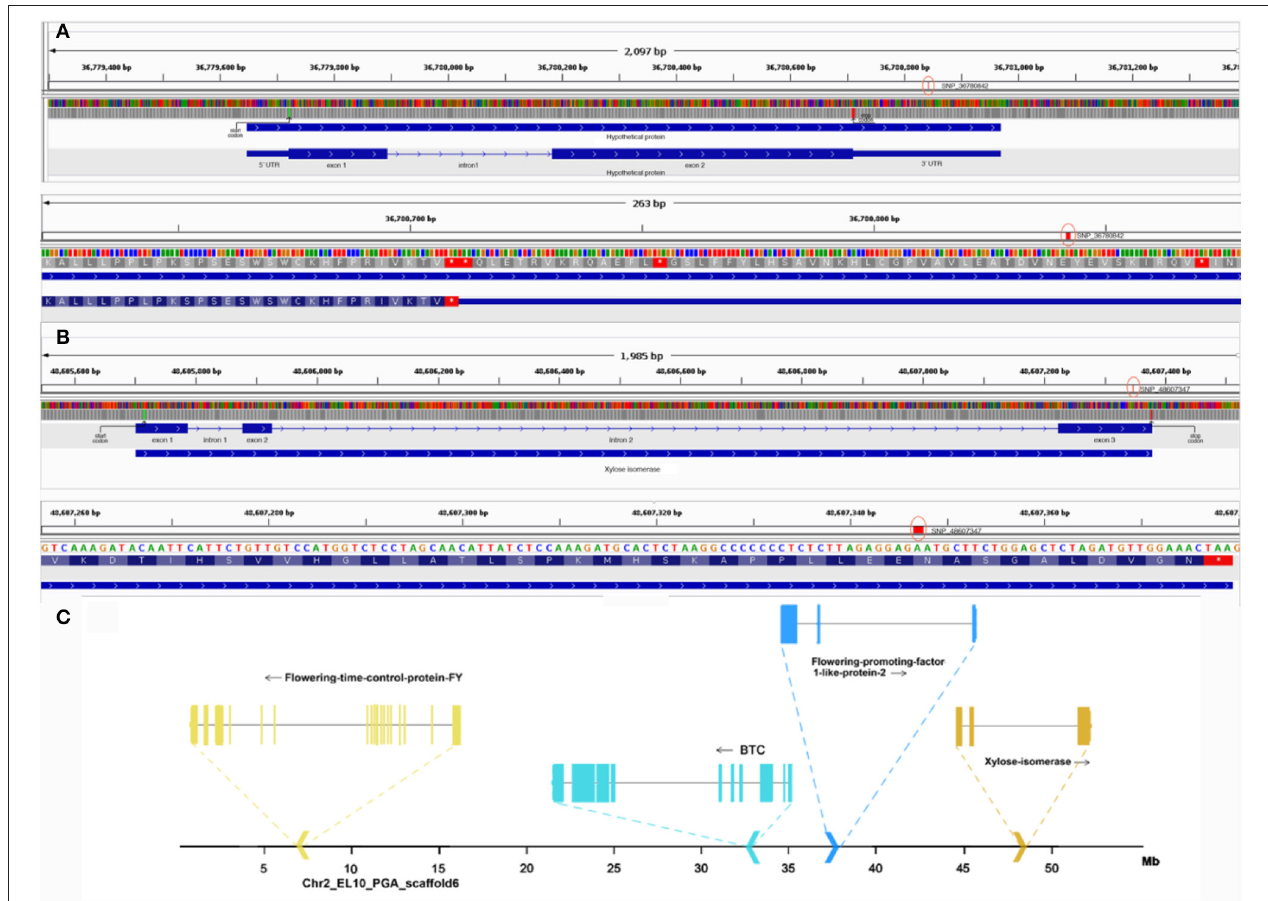
FIGURE 7 | (A) Top: gene structure of hypothetical protein in Chr1 containing SNP_36780842. Here, the green line represents the start codon, red line represents the stop codon and red circle highlights the SNP. Bottom: closer view of SNP_36780842 in context of the 3’ UTR. (B) Top: gene structure of xylose isomerase in Chr2 containing SNP_48607347. Here, the green line represents the start codon, the red line represents the stop codon, and the red circle highlights the SNP. Bottom: closer view of SNP_48607347 in exon 3 of the gene. (C) Chromosomal context of other flowering-related genes in chromosome 2 near the locus of xylose isomerase containing SNP_48607347 is